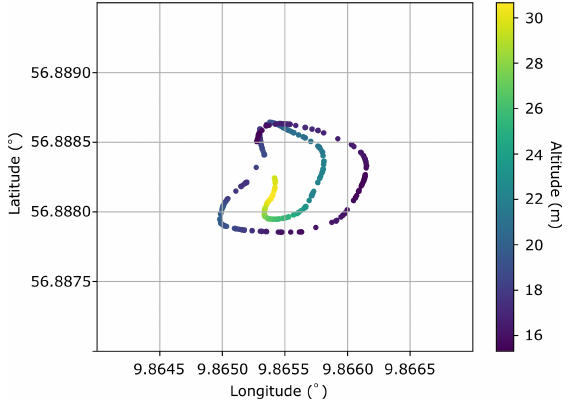
Figure 10. The production flight of the data excerpt shown in Fig. 9. The altitude indicates the in-flight height above mean sea level.